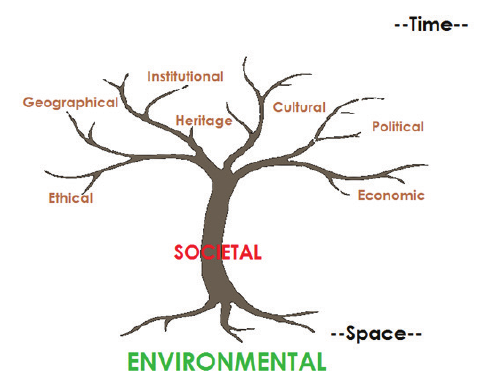
FigUrE 1. “Tree of multidimensional sustainability”: con- ceptual dynamic model of a sustainable society based on cybernetic systems and fractal